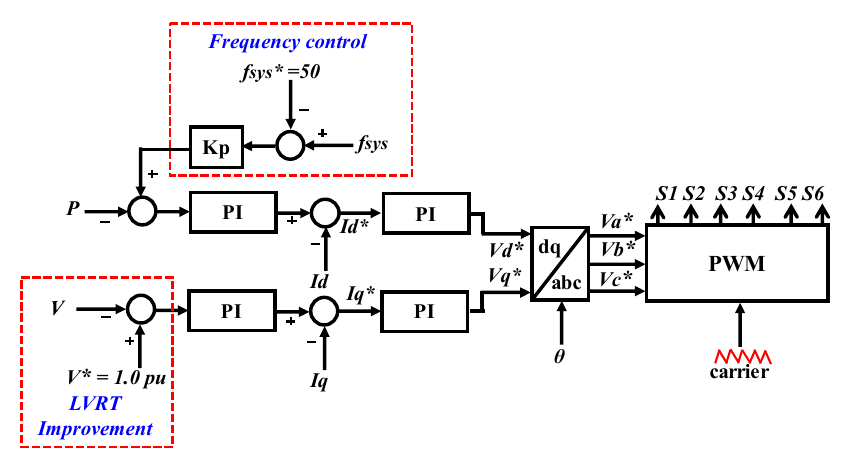
Figure 9. Proposed control strategy of BSS.